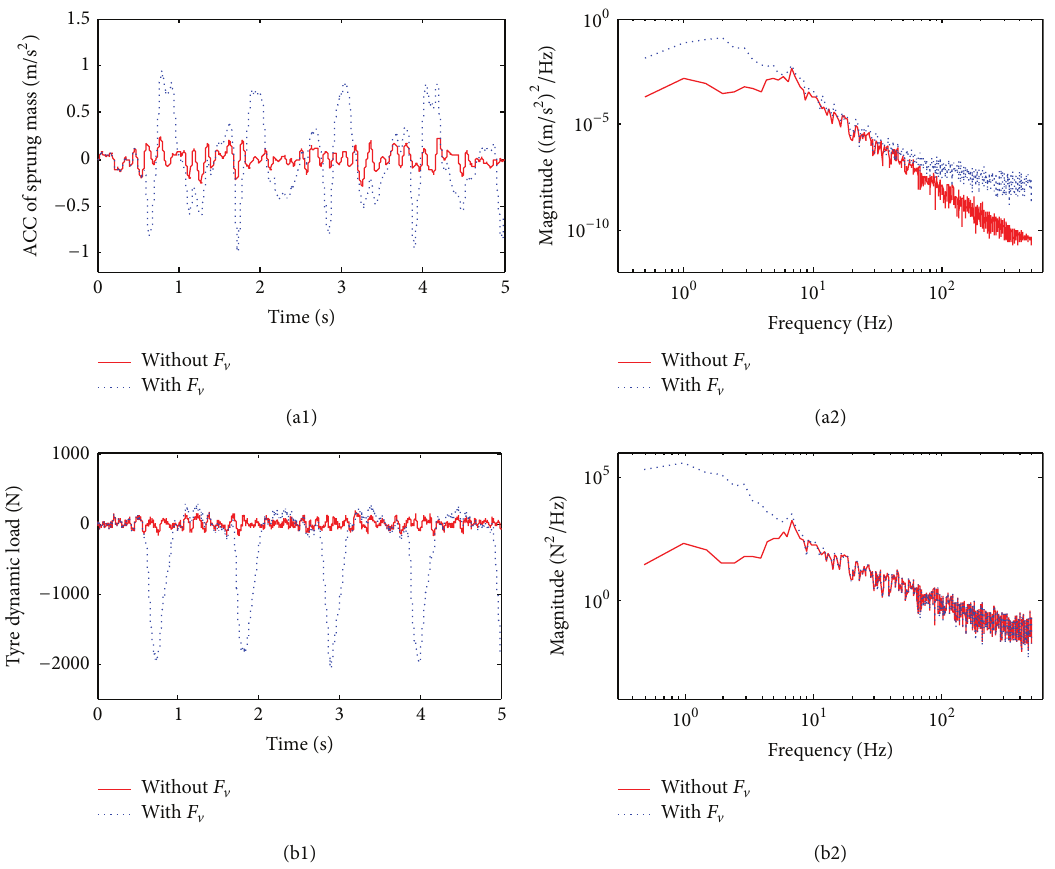
Figure 8: Suspension response to SRM vertical force at velocity 2 km/h. (a1) Time history of sprung mass acceleration. (a2) PSD of sprung mass acceleration. (b1) Time history of tyre dynamic load. (b2) PSD of tyre dynamic load.